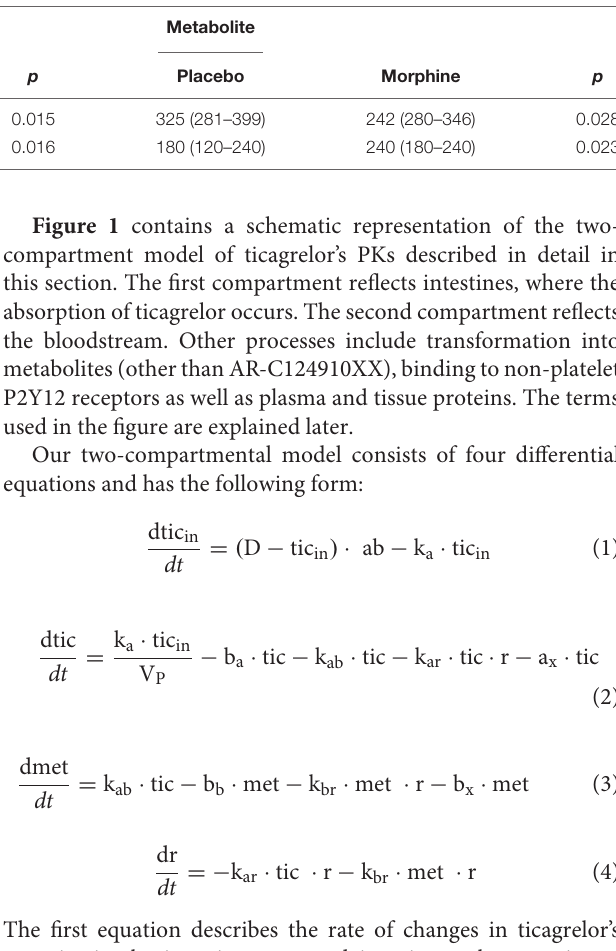
TABLE 1 | Pharmacokinetic parameters of ticagrelor and its active metabolite with loading dose equal to 180 mg (Hobl et al.,